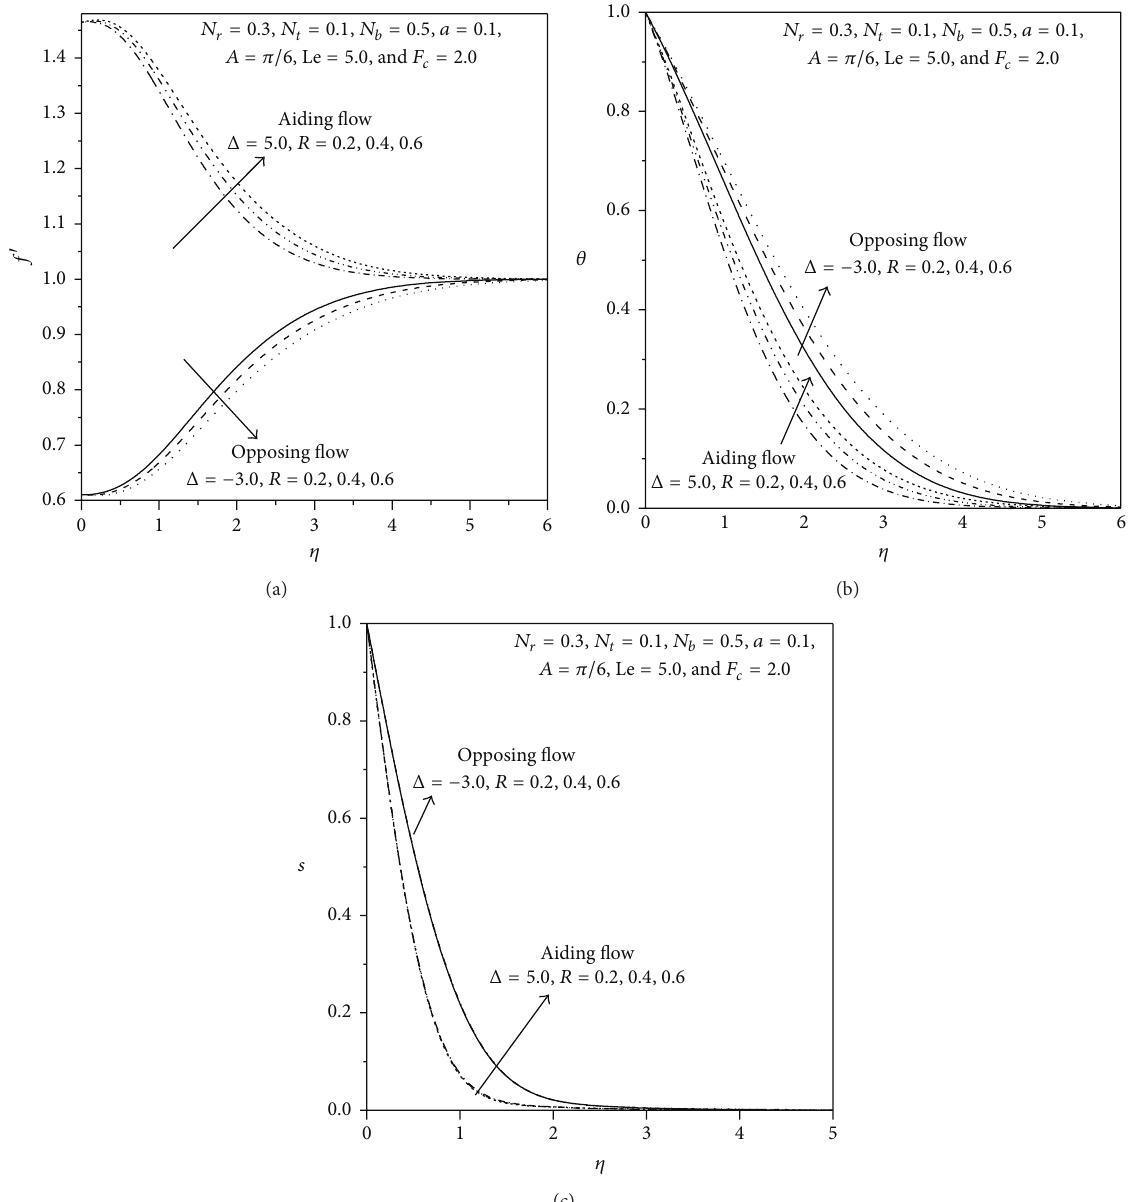
Figure 5: Variation of (a) velocity, (b) temperature, and (c) nanoparticle volume fraction profiles with radiation parameter ( 𝑅 ).